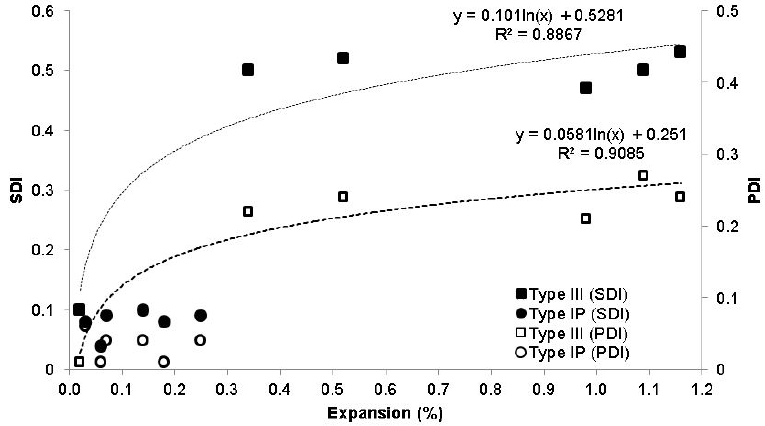
Figure 20. Correlation between expansion, Stiffness Damage Index (SDI), and Plastic Deformation Index